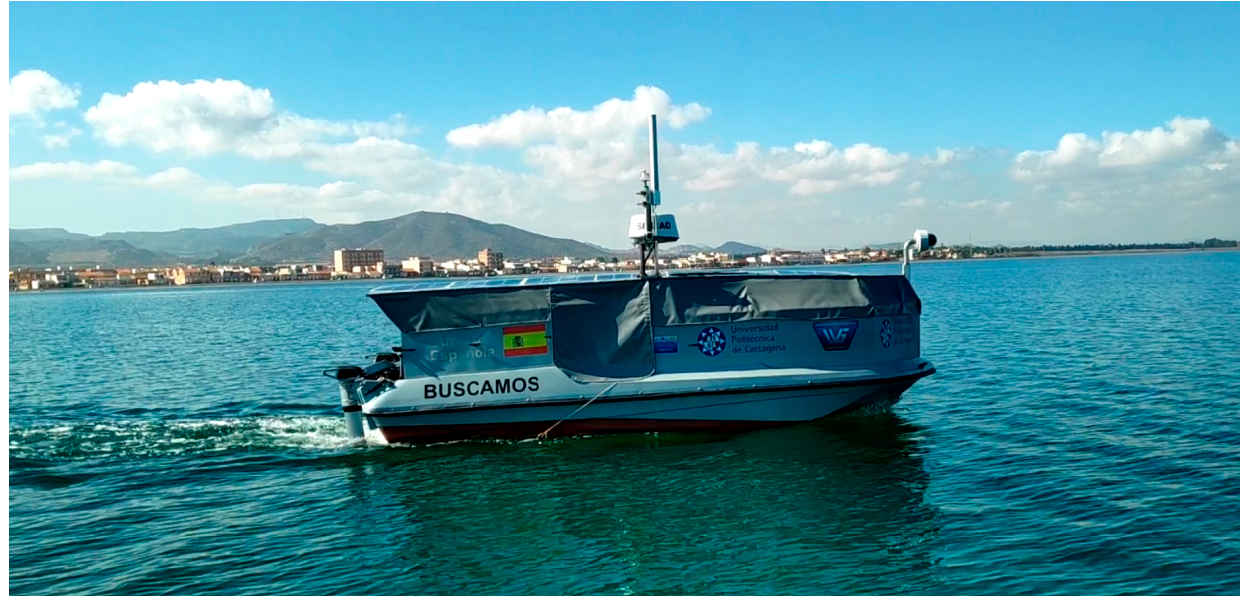
Figure 1. BUSCAMOS ‐ VIGIA autonomous surface vehicle (ASV). Figure 1. BUSCAMOS-VIGIA autonomous surface vehicle